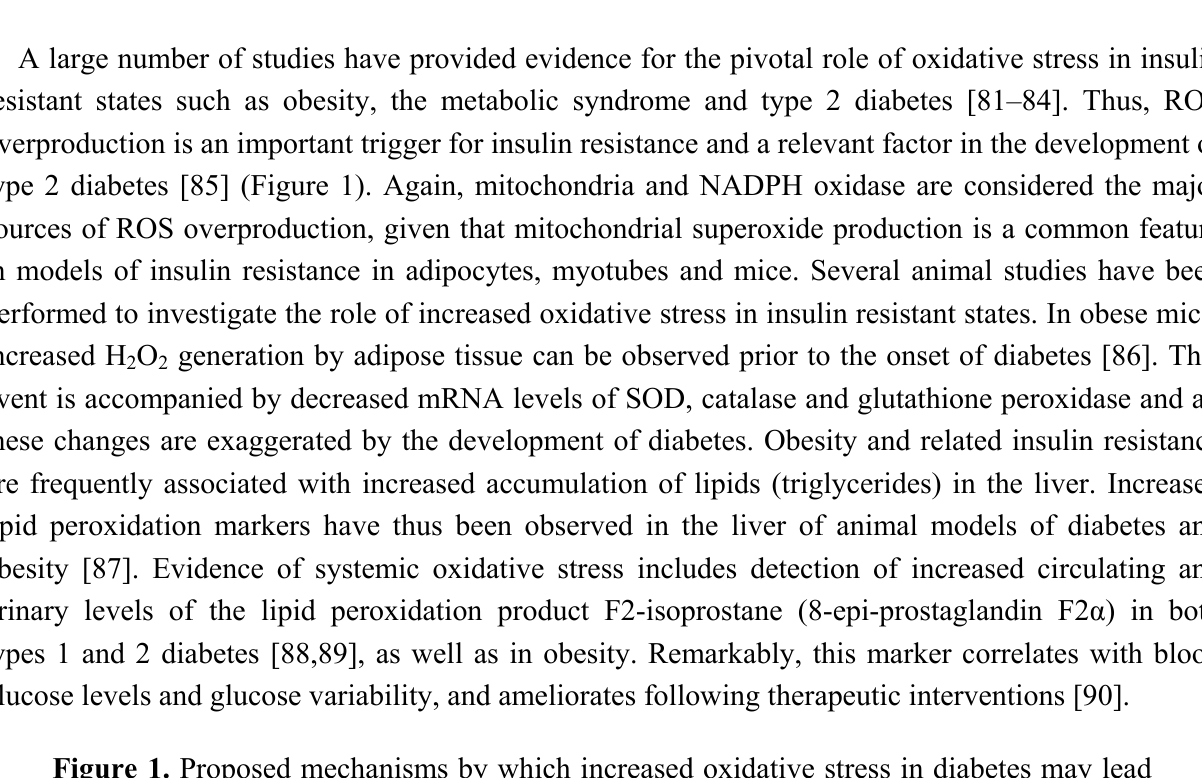
Figure 1. Proposed mechanisms by which increased oxidative stress in diabetes may lead to insulin resistance and atherosclerosis. All abbreviations are spelled out in the text. ↑ indicates increased levels; ↓ indicates decreased